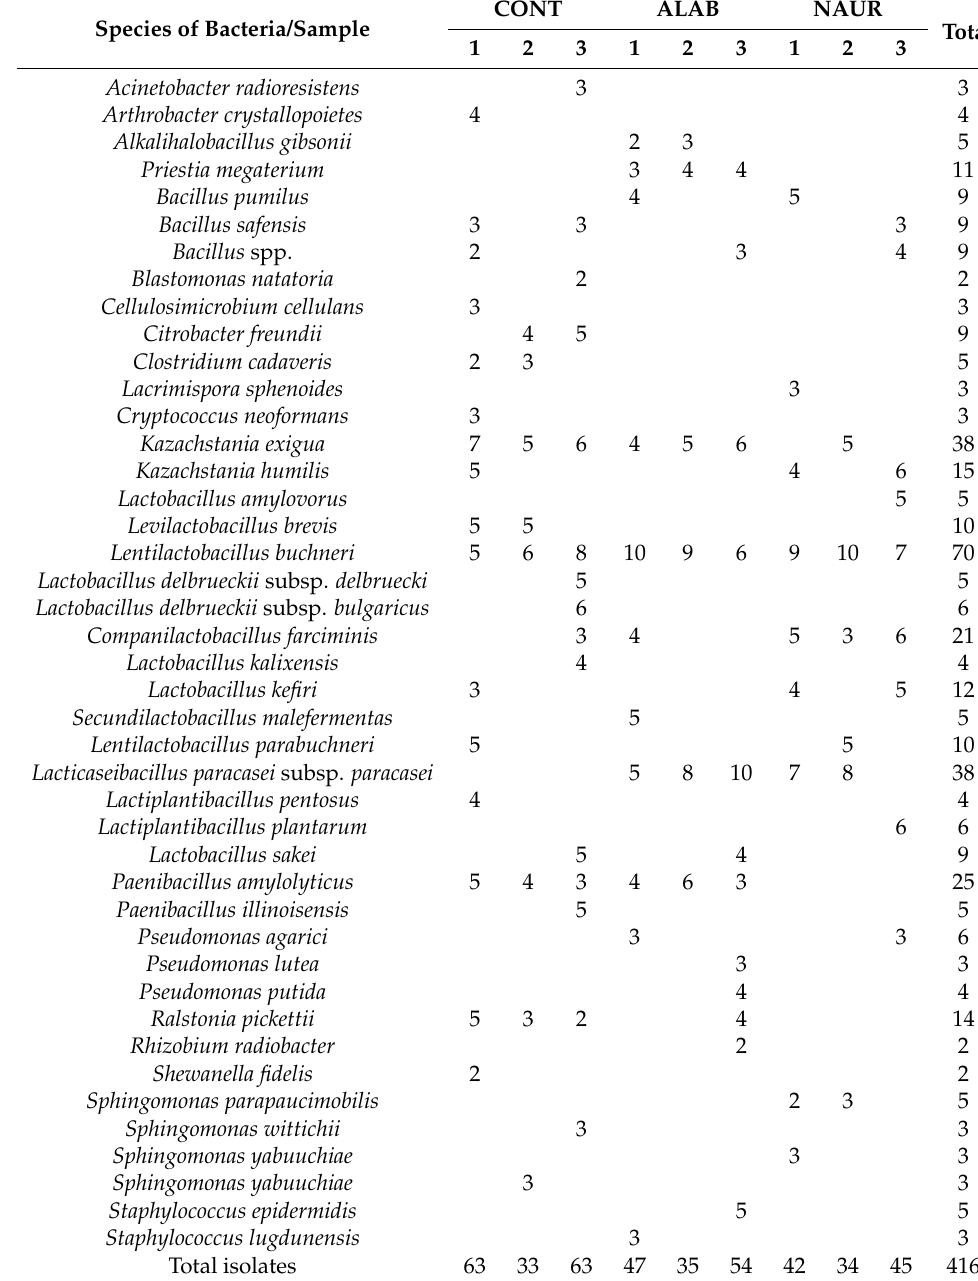
Table 3. The number of isolated species of bacteria and yeasts from corn silage. Species of